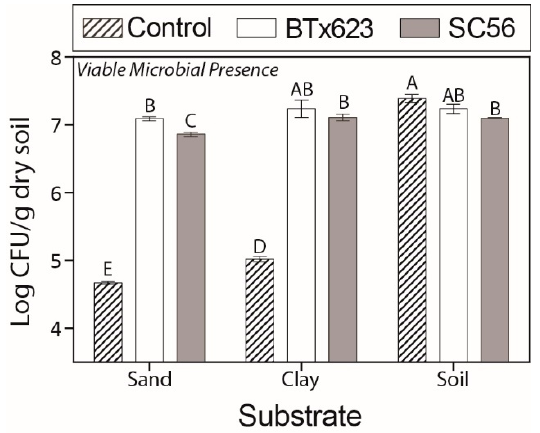
Figure 1. Viable microbial presence. Least square means and standard error of means (vertical bars) for the detected, culturable microorganisms for each treatment within each substrate. Uppercase letters indicate statistical significance (Student’s t ) between means assessed among all substrates and genotypes.